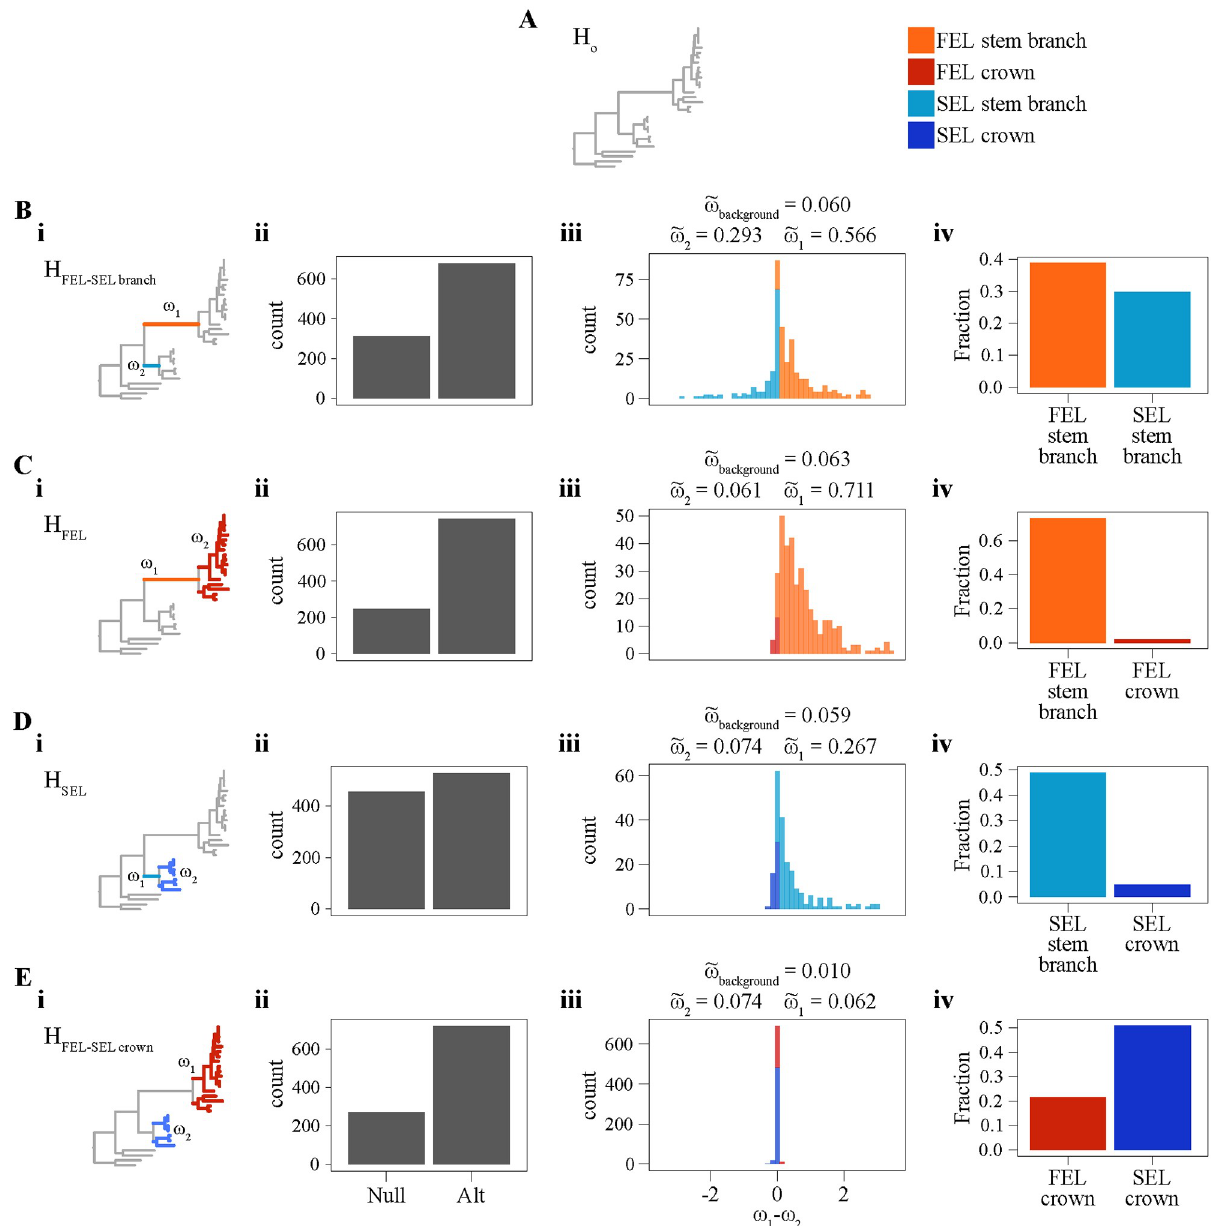
Fig 5. dN/dS ( ω ) analyses support a historical burst of accelerated evolution in the FEL. (A) The null hypothesis (H O ) that all branches in the phylogeny have the same ω value. Alternative hypotheses (B–E) evaluate ω along three sets of branches. (Bi) The alternative hypothesis (H FEL–SEL branch ) examined ω values along the FEL and SEL stem branches. (Bii) 311 (31.45%) genes supported H O , and 678 (68.55%) genes supported H FEL–SEL branch . (Biii) Among the genes that supported H FEL–SEL branch , we examined the distribution of the difference between ω 1 and ω 2 as specified in part Bi. Here, a range of ω 1 – ω 2 of − 3.5 to 3.5 is shown in the histogram. Additionally, we report the median ω 1 and ω 2 values, which are 0.57 and 0.29, respectively. (Biv) 384 (38.83%) genes significantly rejected H O and were faster in the FEL than the SEL, while 237 (23.96%) significantly rejected H O and were faster in the SEL than the FEL. (Ci) The alternative hypothesis (H FEL ) examined ω values along the FEL stem branch ( ω 1 ) and crown branches ( ω 2 ). (Cii) 246 (24.87%) genes supported H O , and 743 (75.13%) genes supported H FEL . (Ciii) Among the genes that supported H FEL , we examined the distribution of the difference between ω 1 and ω 2 as specified in part Ci. The median ω 1 and ω 2 values were 0.71 and 0.06, respectively. (Civ) 725 (73.31%) genes significantly rejected H O and had higher ω 1 values than ω 2 values, while 18 (1.82%) genes significantly rejected H O and had higher ω 2 than ω 1 values. (Di) The alternative hypothesis (H SEL ) examined ω values along the SEL stem branch ( ω 1 ) and crown branches ( ω 2 ). (Dii) 455 (46.29%) genes supported H O , and 528 (53.71%) genes supported H SEL . (Diii) Among the genes that supported H SEL , we examined the distribution of the difference between ω 1 and ω 2 as specified in part Di. The median ω 1 and ω 2 values were 0.27 and 0.07, respectively. (Div) 481 (48.93%) genes significantly rejected H O and had higher ω 1 than ω 2 values, while 47 (4.78%) genes significantly rejected H O and had higher ω 2 than ω 1 values. (Ei) The alternative hypothesis